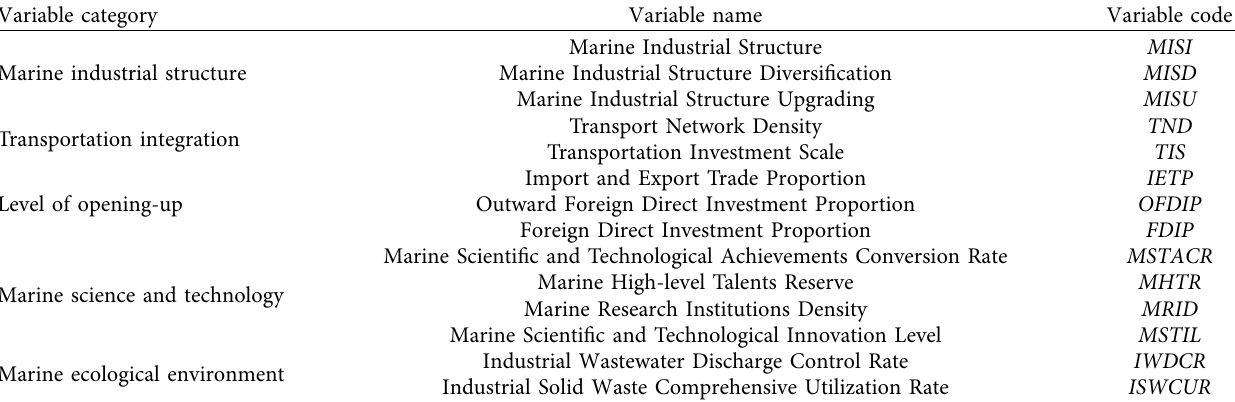
Table 1: Drivers of marine economic efficiency under the Belt and Road Initiative